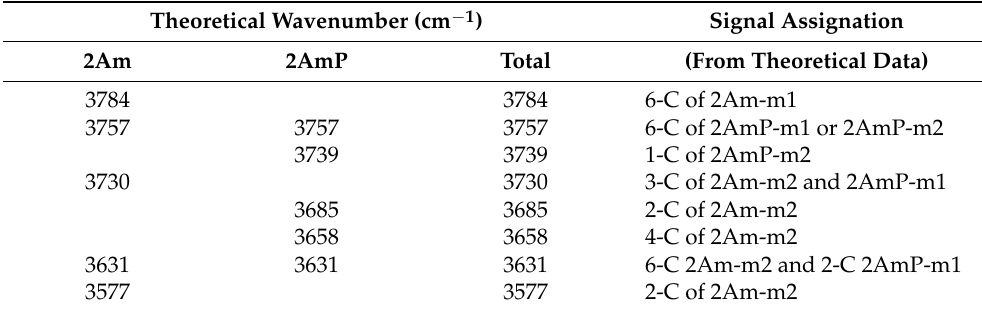
Table 1. Signals between 3800 and 3500 cm − 1 obtained through DFT calculations for dimers of amylose (2Am) and amylopectin (2AmP).